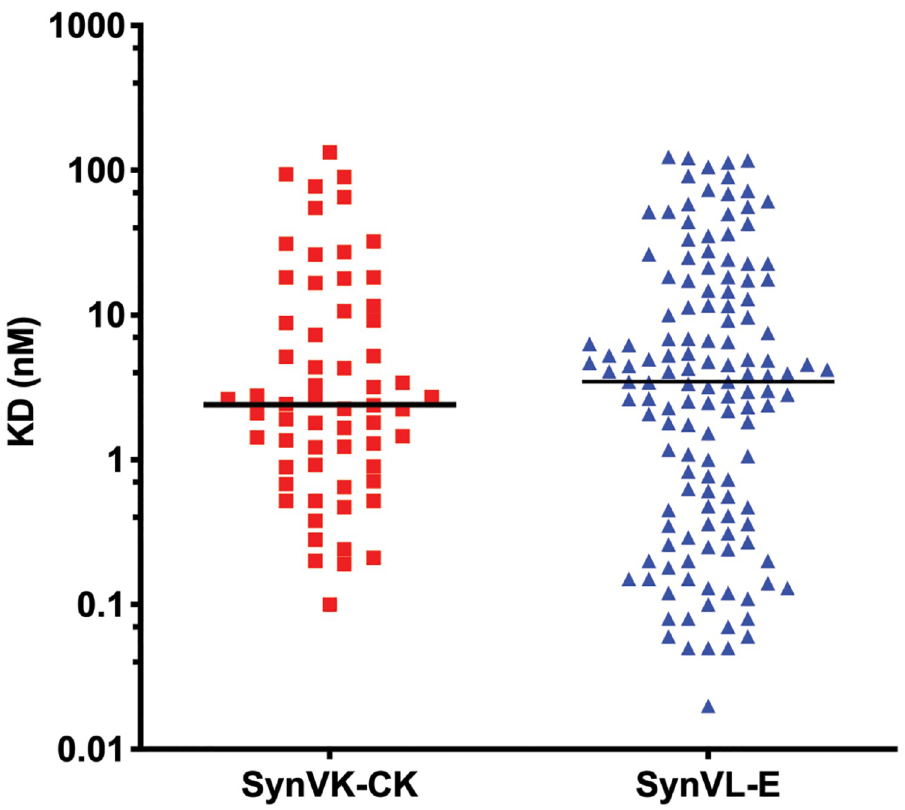
Fig 6. V λ -derived antibodies reach subnanomolar affinities. Progranulin affinity was measured from a subset of V λ (right) and previously described V κ (left) antibodies. The V κ cohort had a slightly higher median affinity (2.4 nM) compared to the V λ cohort (3.5 nM), but the difference was not statistically significant (Student’s T-test, p = 0.65).